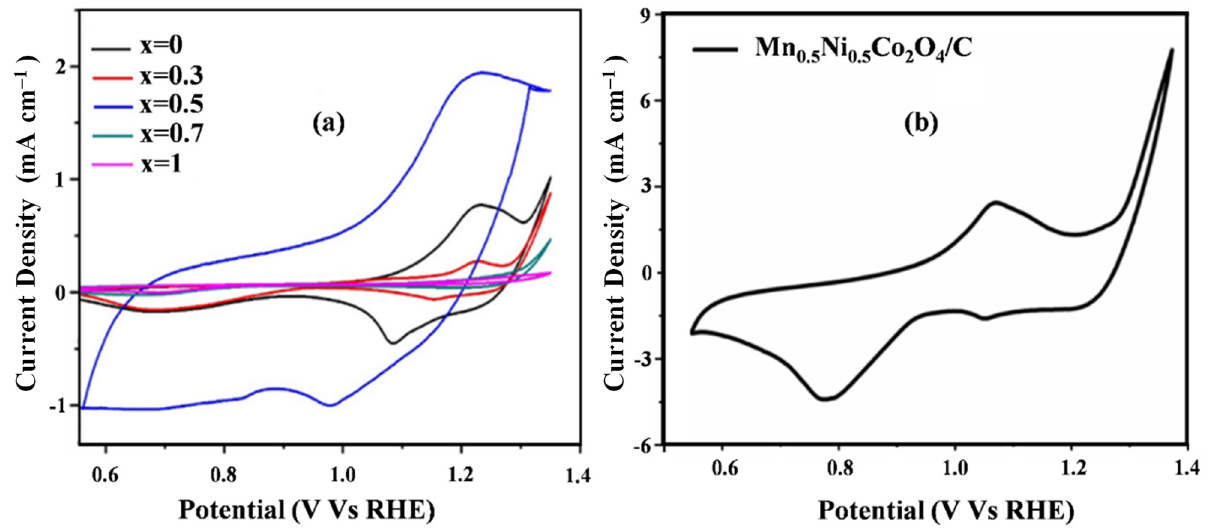
Figure 7. ( a ) CV comparison of Mn x Ni 1 − x Co 2 O 4 (x = 0, 0.3, 0.5, 0.7, and 1), ( b ) Mn 0.5 Ni 0.5 Co 2 O 4 /C in O 2 -saturated 0.1 M KOH recorded at 50 mV s − 1 .